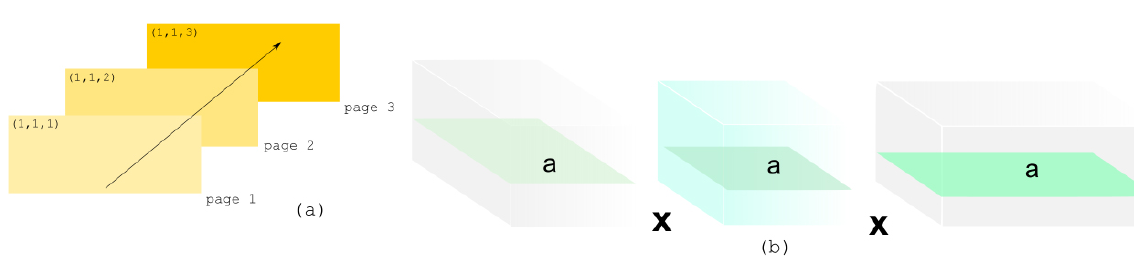
Figure 6. Interpretation of the concept of multidimensional arrays: (a) several pages of the same index, (b) the multidimensional product applied to the problem, with evidence for the 𝛼 𝛼 𝛼